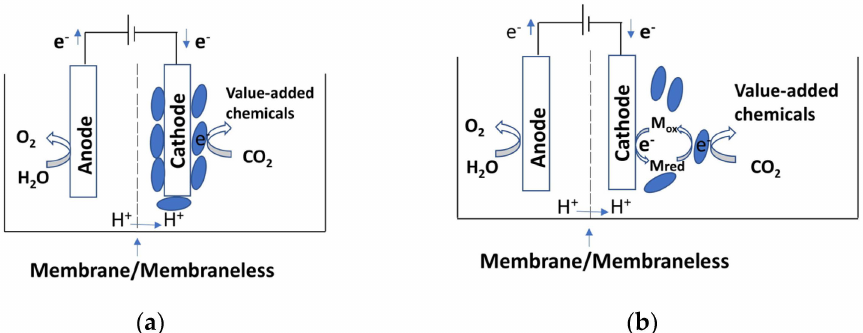
Figure 1. Schematic of two representative systems in electrochemical reduction of CO 2 to produce value-added chemicals catalyzed by whole-cell biocatalysts. ( a ) In direct EET [38]; ( b ) in indirect